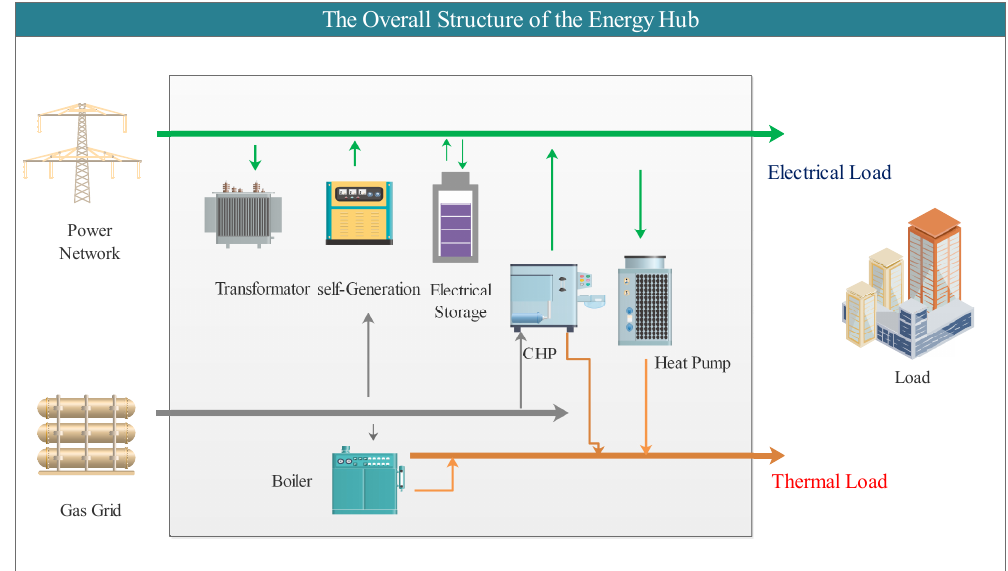
Figure 1. The overall structure of energy hubs containing both retailer and